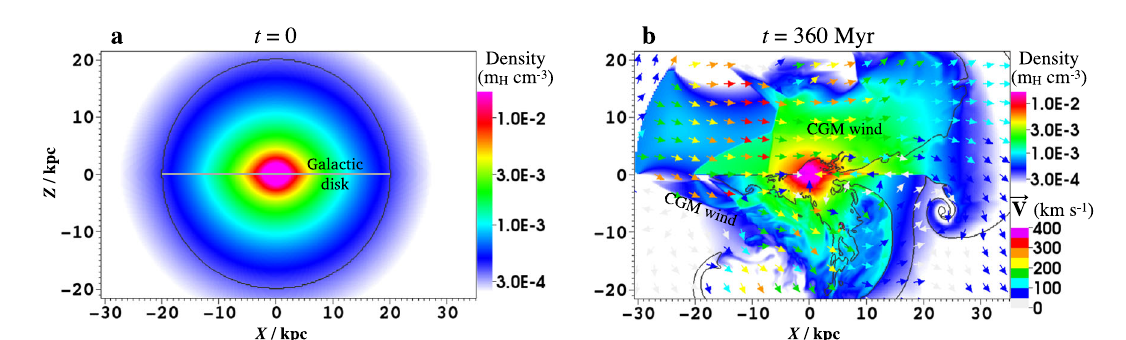
Fig. 3 | Density distribution. Panel a shows the initial density distribution of the hot halo ( Y =0), and the grey line denotes the Galactic disk. Panel b shows the density and velocity (arrows) at t =360 Myr, with black contours representing the boundary of the initial halo medium. Due to the shielding of the Galactic disk,